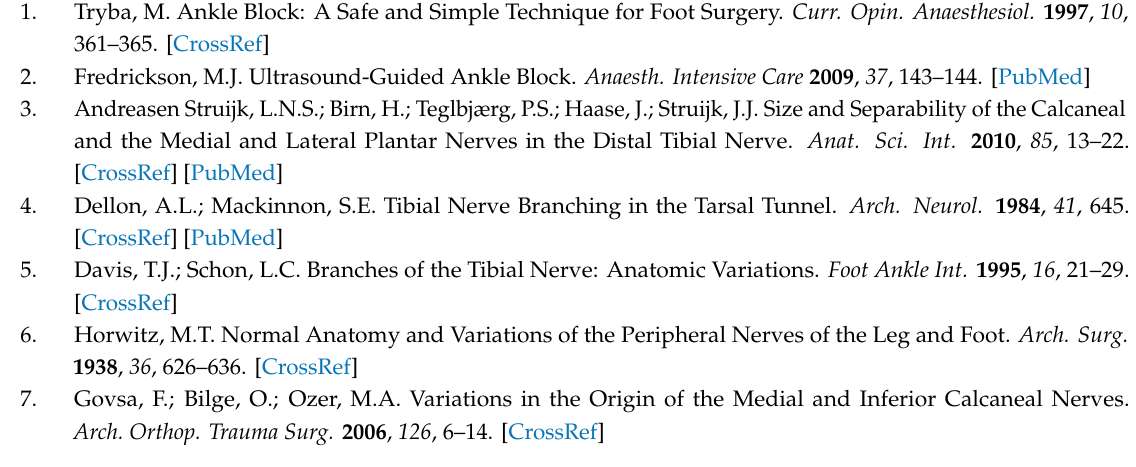
Table S1: Consort